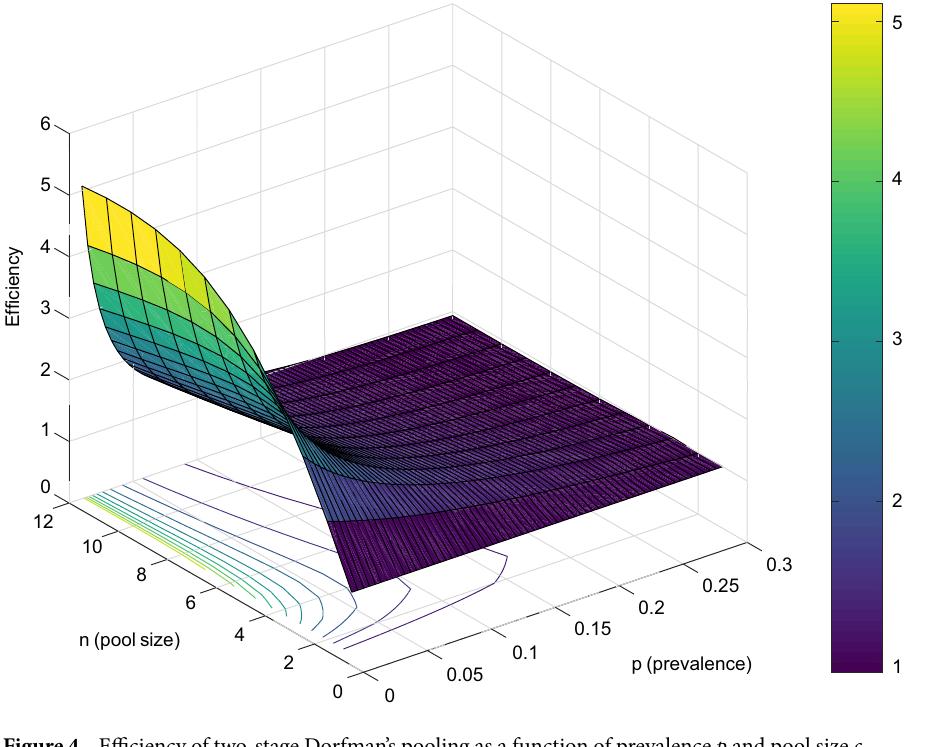
Figure 4. Efficiency of two-stage Dorfman’s pooling as a function of prevalence p and pool size c .